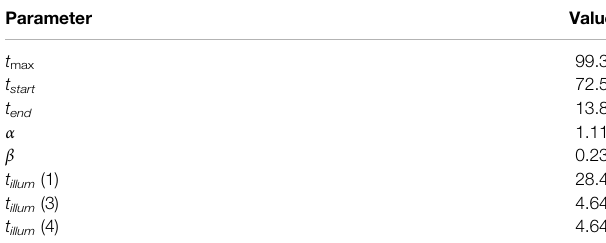
TABLE 3 | Parameters of the optimized 5-oscillator